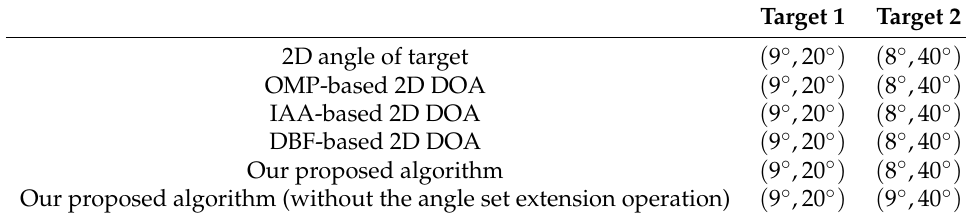
Table 3. DOA estimation